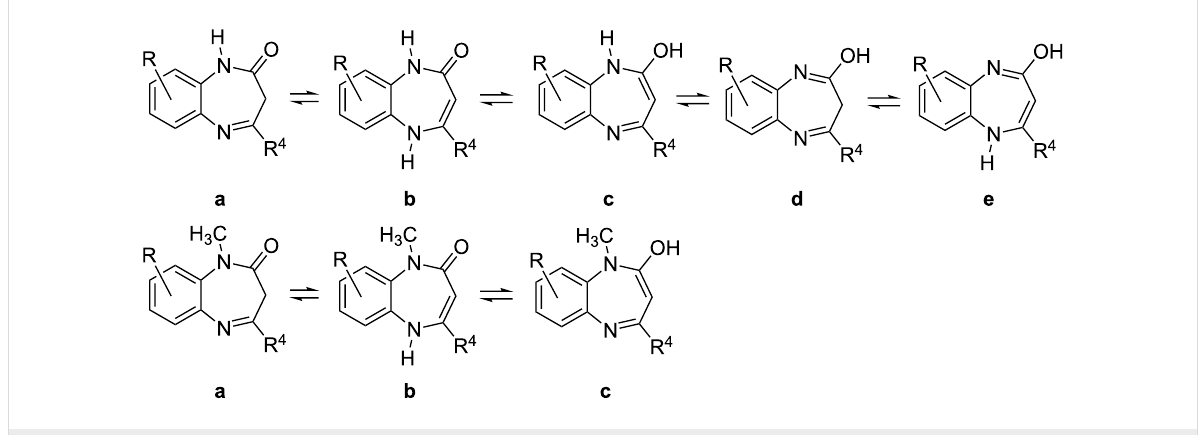
Figure 7: The different tautomers in the 1 H and 1-methyl series.